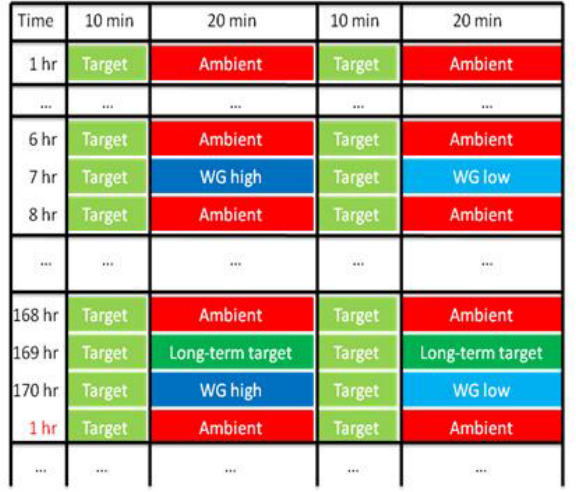
Fig. 4. Measurement cycle of the CRDS system for target, ambient air, working gases and long-term target. Note that the first 3min of each measurement is neglected to ensure an adequate flushing of the optical cell.